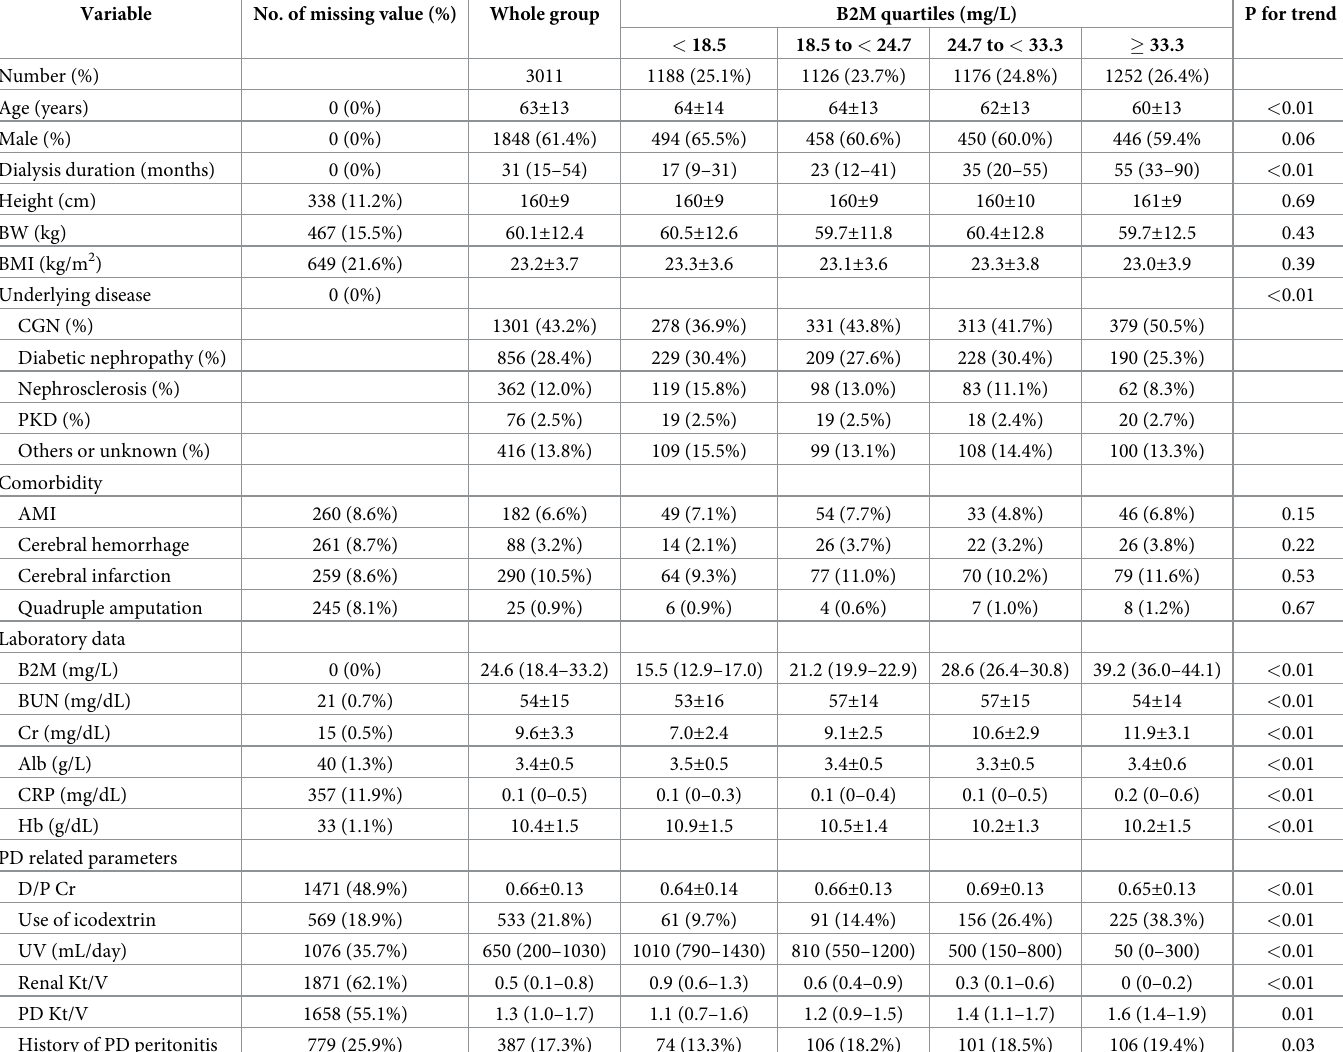
Table 1. Baseline characteristics of 3011 PD patients by quartiles of serum